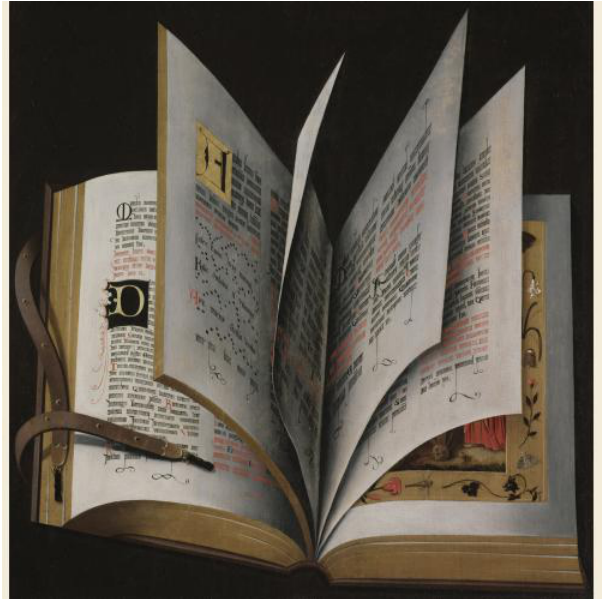
Figure 4. Trompe l’œile painting depicting a book. Attrib. Ludger tom Ring